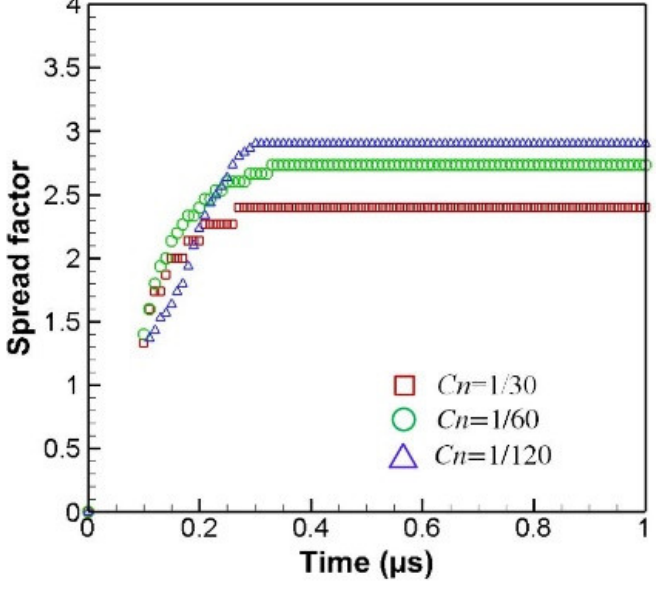
Figure 3. Temperature distribution for ( a ) Cn = 1/30 and ( b ) Cn = 1/60 at 0.6 μs. The white contour denotes drop profile and the temperature is measured in K. The substrate surface is denoted in black.